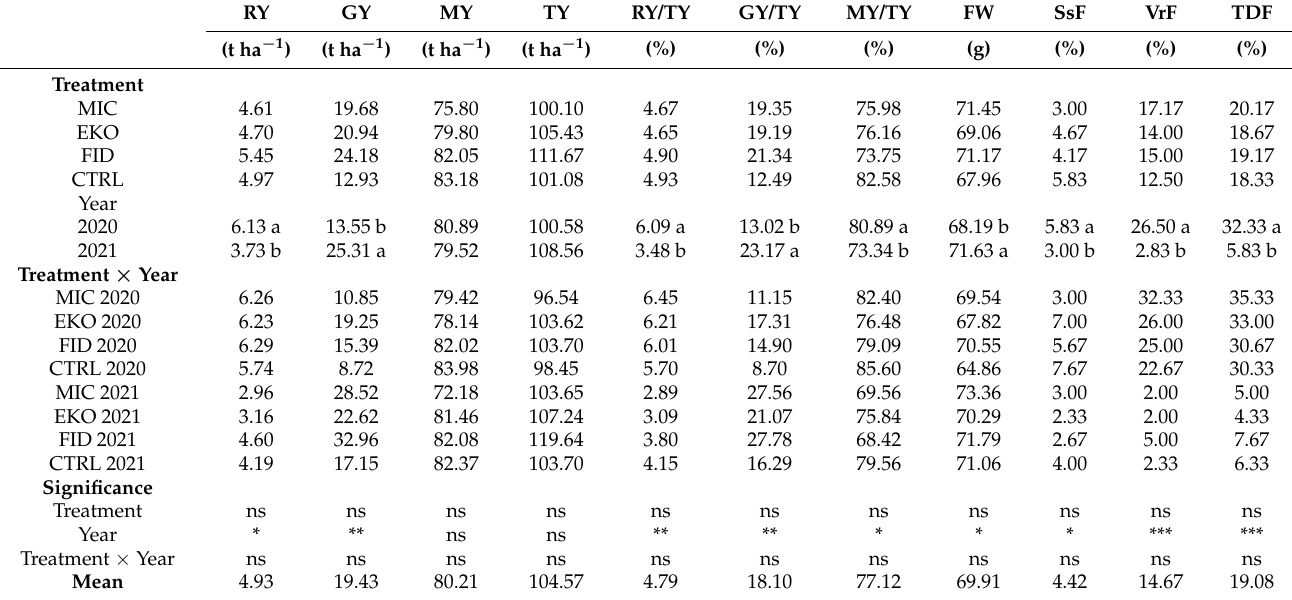
Table 1. Effects of treatments (MIC = Micosat F Tab Plus, EKO = EKOprop NX, FID = Fidelius, CTRL = control), year and treatment × year interaction on yield components and fruit defects (cv “Heinz